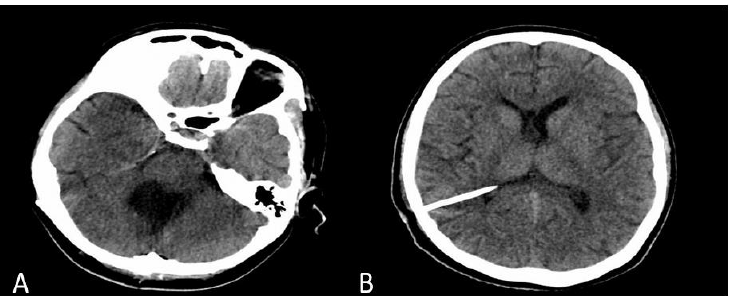
Figure 1. MRI scan, axial section, FLAIR sequence ( A ) and coronal section, T2 sequence ( B ), showing a large intraventricular tumor, located in the 4th ventricle . Enlargement of the lateral and third ven- tricles and transependimar resorption ( C , D ).